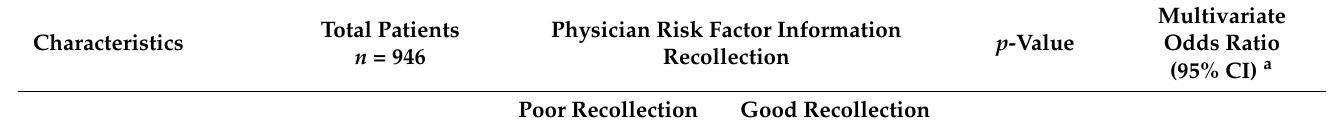
Table 1. Demographic and Clinical Characteristics of Patients’ Recollection of CVD Risk Factor Information from Physicians in Chronic Coronary Syndrome